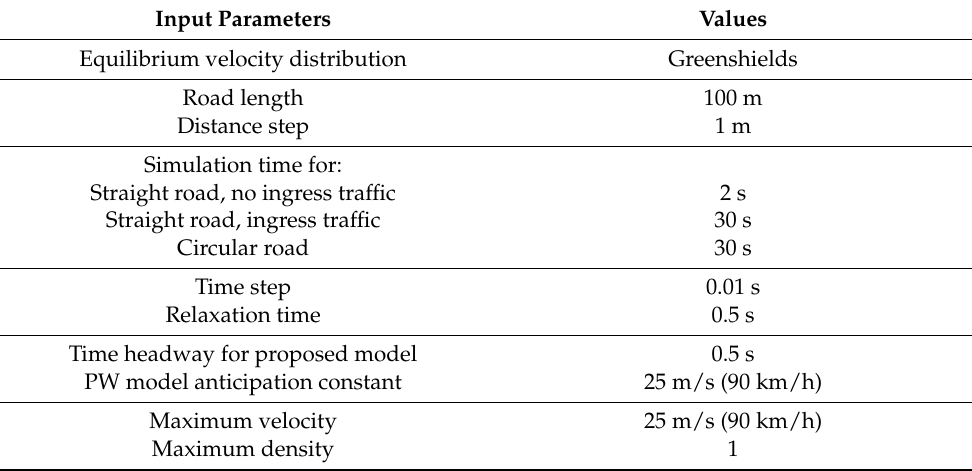
Table 3. Input parameters for the numerical simulation of the proposed and PW models.